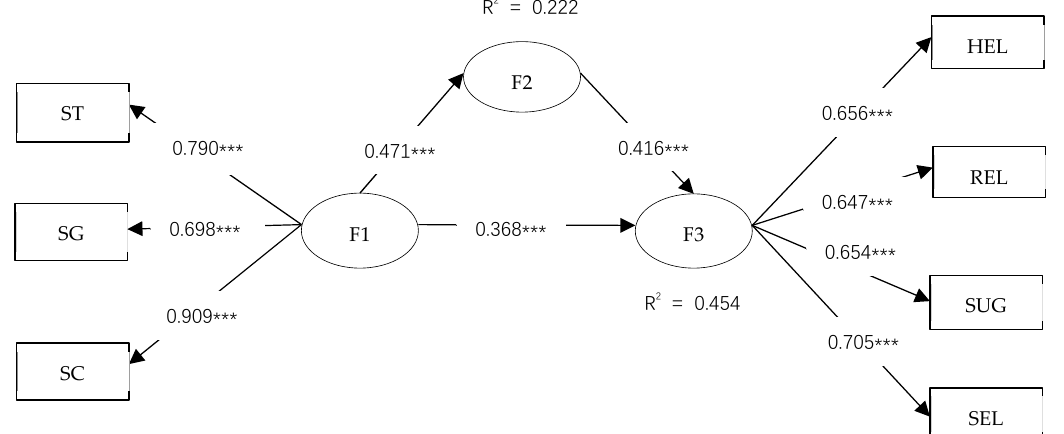
Figure 3. Results of the mediated model. Values on the paths are the standardized path coefficients. R 2 represents the amount of variance the factor is accounted for in the model. *** At the 0.001 level, the correlation is significant. F1 is social safety capital, F2 is autonomous safety motivation, and F3 is safety citizenship behavior. HEL is mutual aid among workers; REL is the relationship between superior and subordinate; SUG is the participation of suggestion-making; SEL is self-control; SM is autonomous safety motivation; ST is safety trust; SG is safety goal; and SC is safety communication.